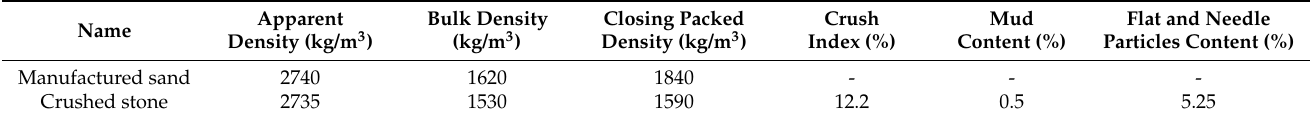
Table 2. Basic physical and mechanical properties of aggregates.